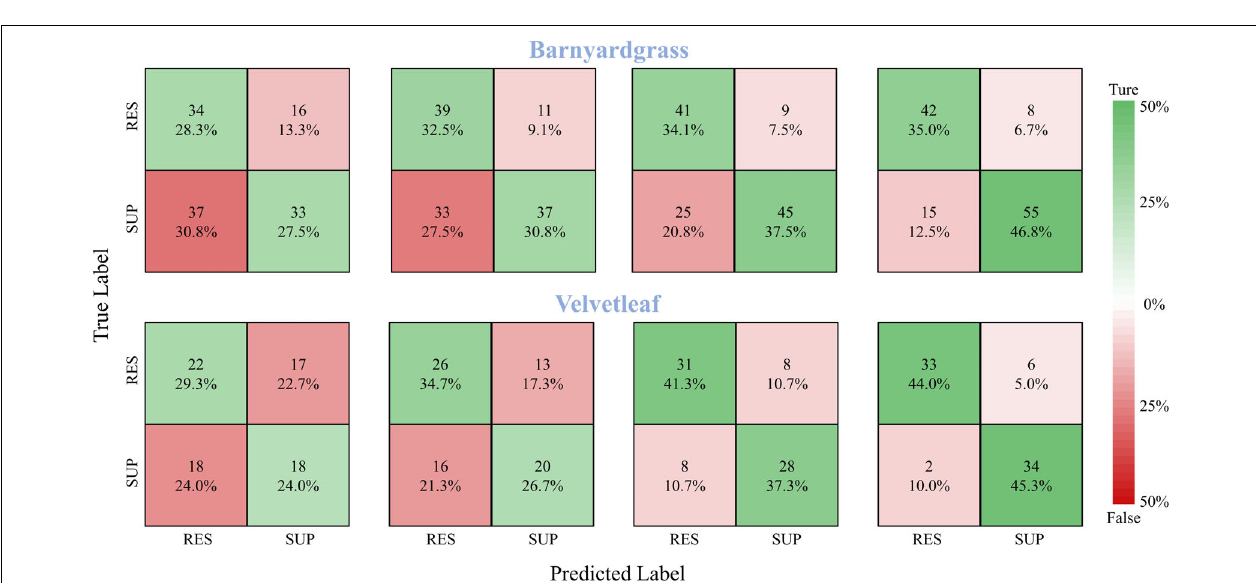
FIGURE 8 | Confusion matrices for barnyardgrass and velvetleaf in the validation area. RES are resistant weeds. SUP are susceptible weeds.